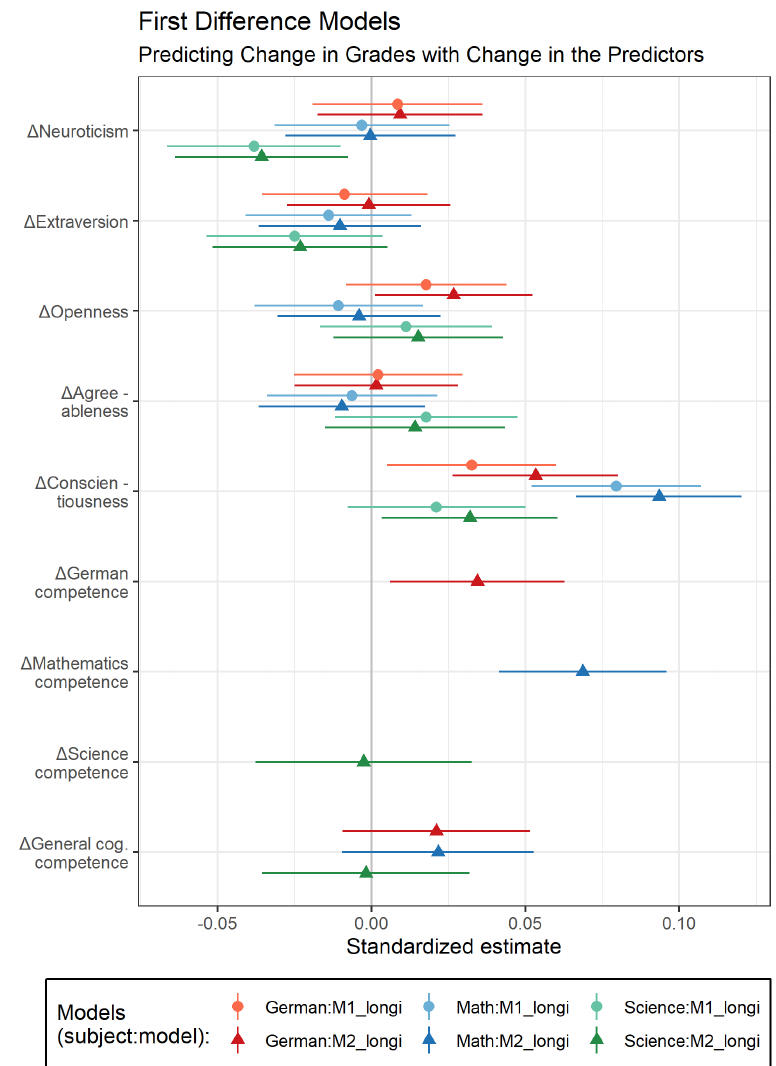
Figure 3. Standardized estimates for the longitudinal models.